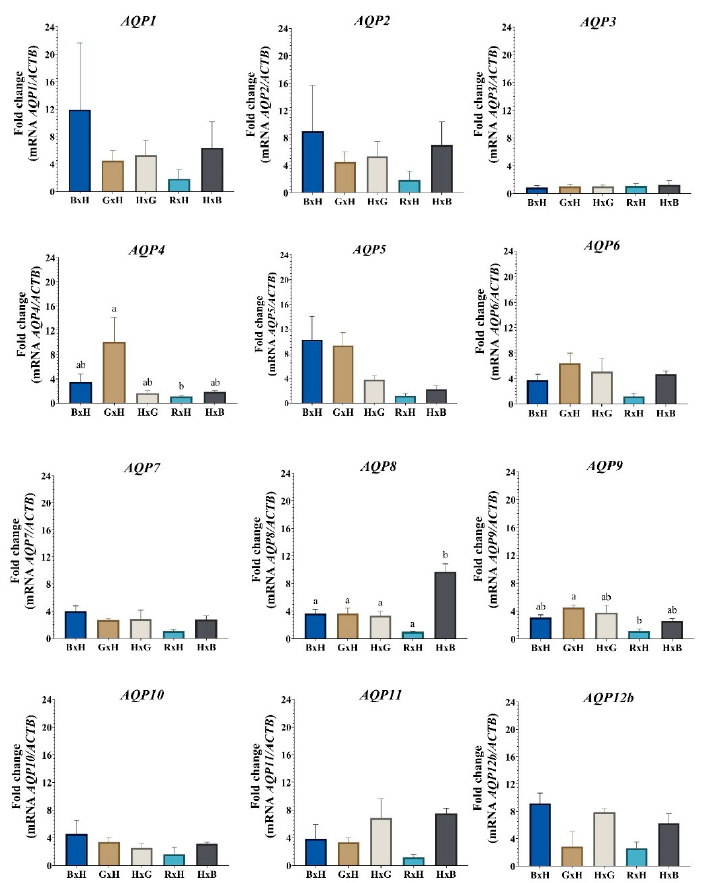
Figure 2. Relative expression of aquaporin gene transcripts in cattle embryos. BxH : ♀ Brahman × ♂ Holstein, GxH : ♀ Gir × ♂ Holstein, HxG : ♀ Holstein × ♂ Gir, RxH : ♀ Romosinuano × ♂ Holstein, and HxB : ♀ Holstein × ♂ Brahman. Different letters (a and b) denote statistical differences ( p < 0.05). AQPs names in italics denote its mRNA expression levels.